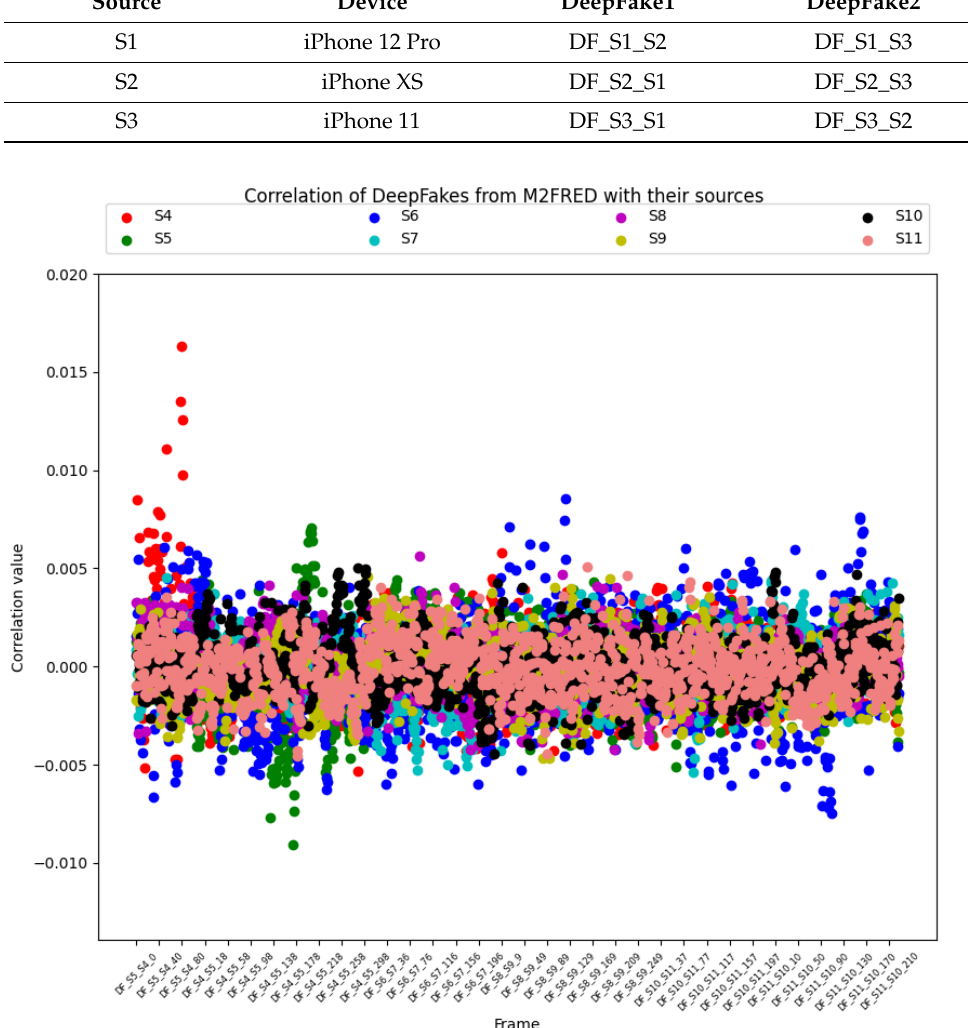
Figure 7. Correlation value between deep fake videos generated from the M2FRED dataset and their